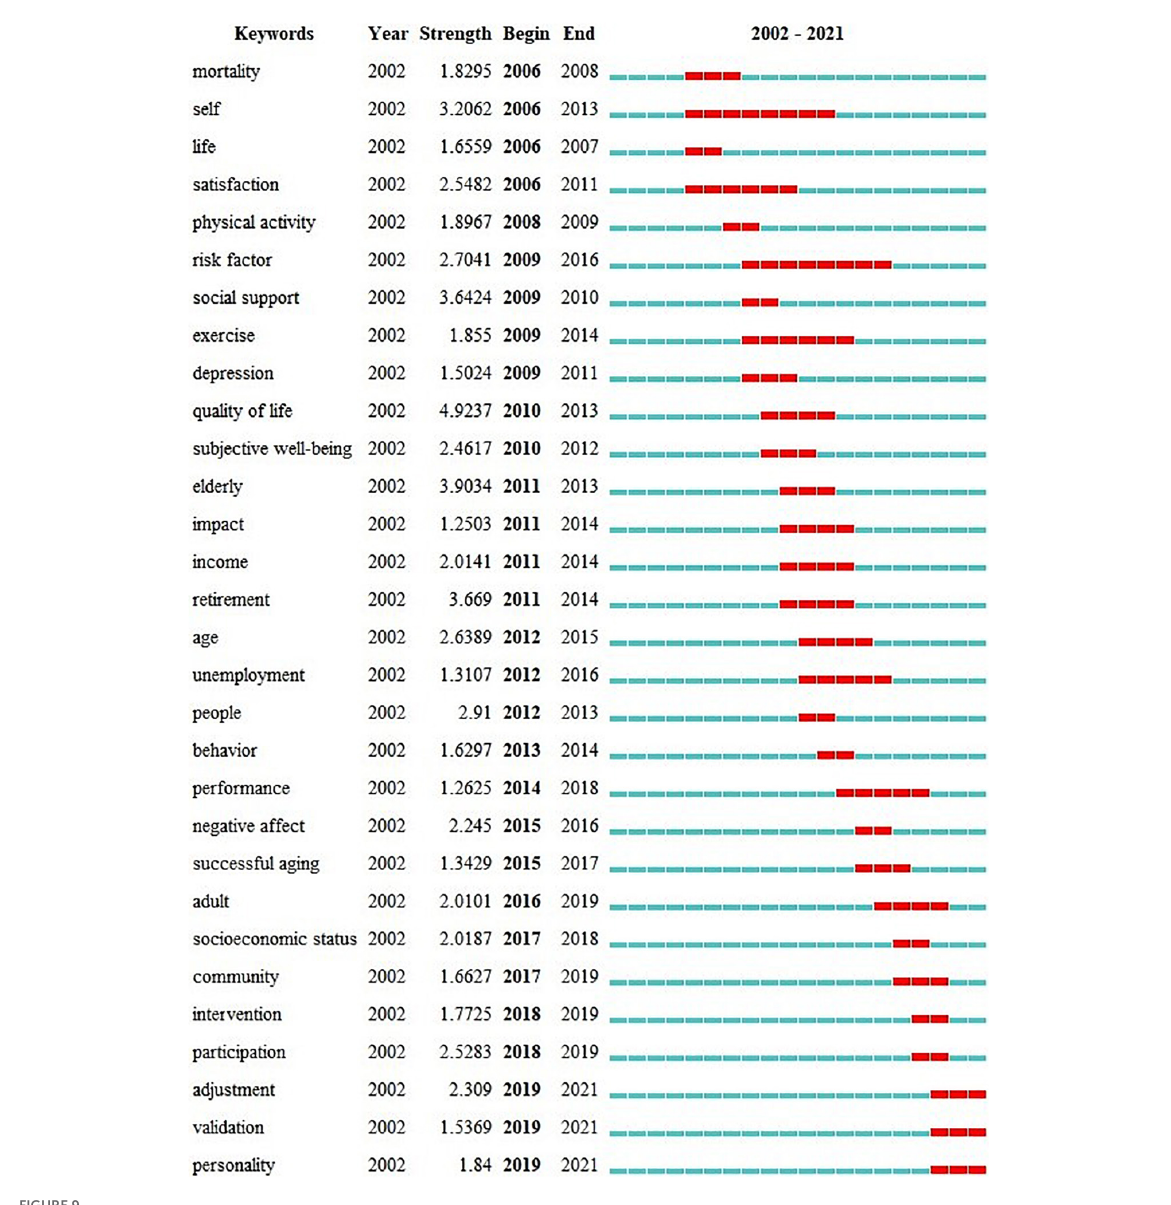
FIGURE9 Top 30 keywords with the strongest citation bursts. Red bars indicate the citation bursts of keywords. The strength of a keyword indicates how often it was cited during the burst